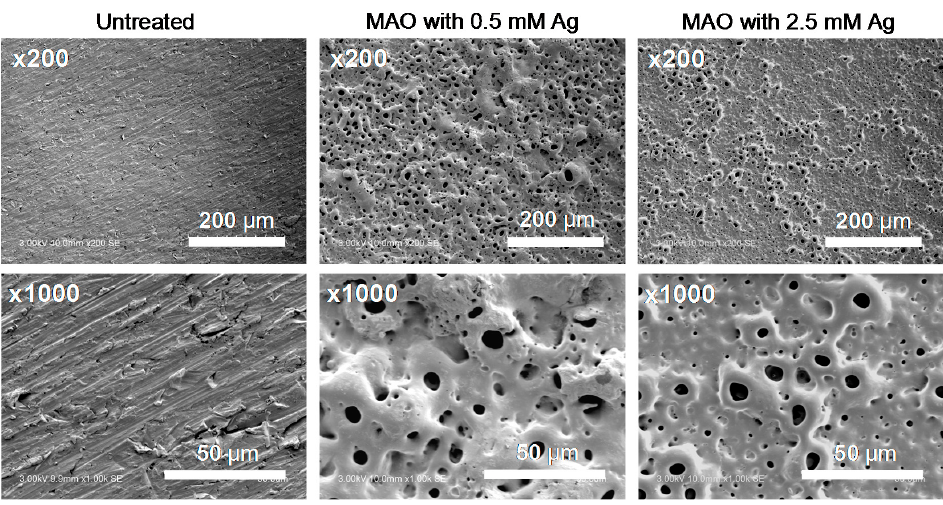
Figure 1. Scanning electron micrographs of TNTZ before and after MAO treatment.